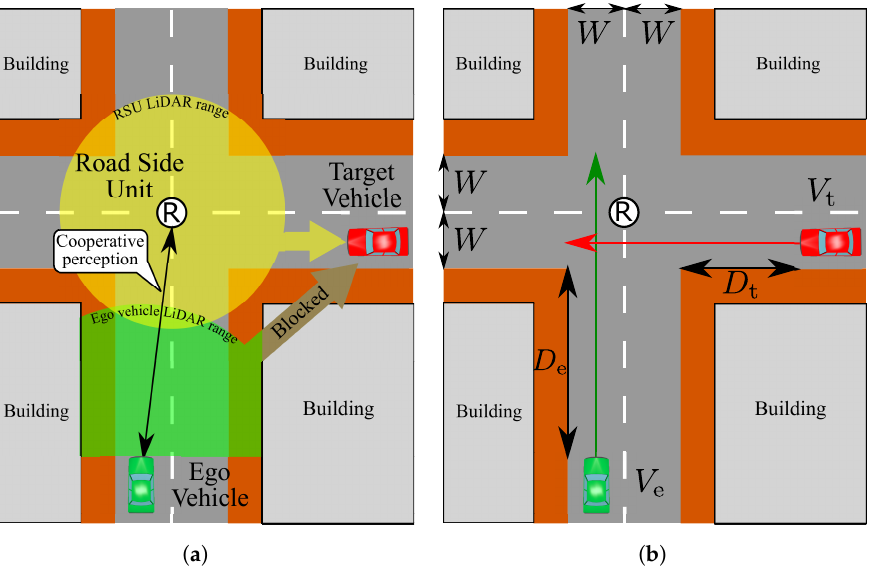
Figure 1. Overview of LiDAR sensors and the driving pattern at the unsignalized intersection: ( a ) The location and the range of LiDAR sensors. ( b ) The driving pattern of both ego and target